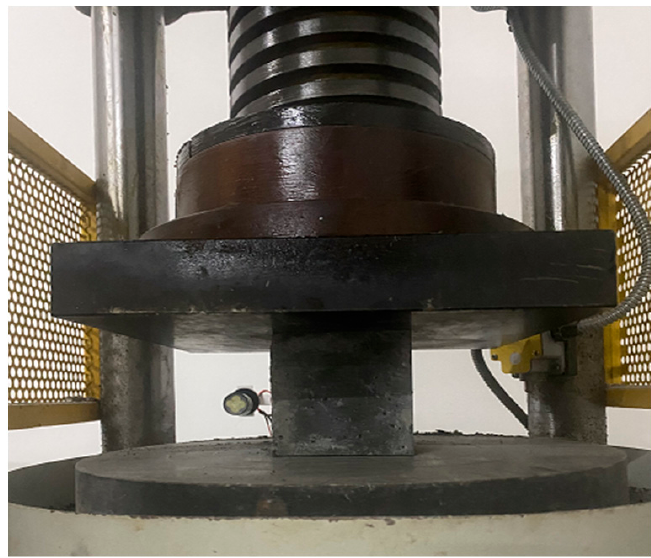
Figure 1. Loading diagram of cube compressive test.